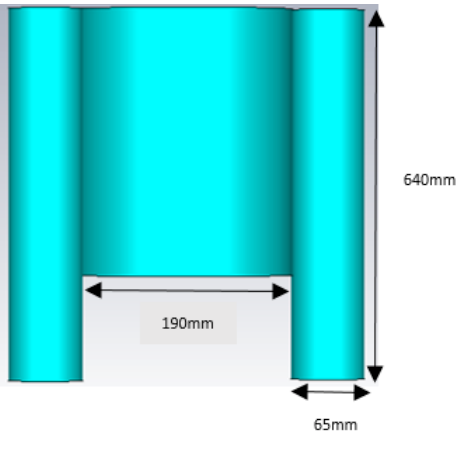
Figure 1: Cylindrical Phantom model